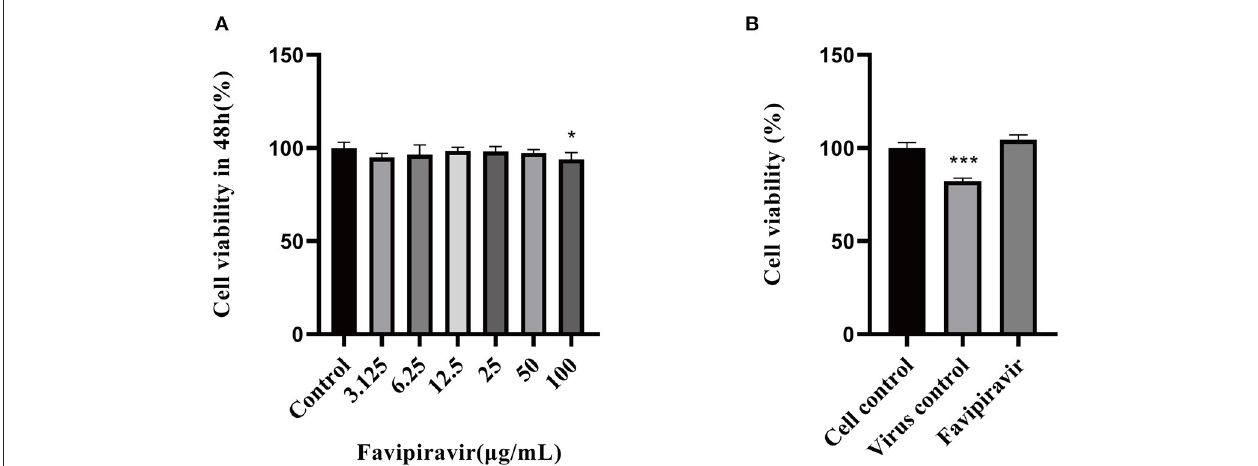
FIGURE 1 | Determination of the maximal noncytotoxic concentration of favipiravir. (A) The viability of Vero cells treated with serial dilutions of favipiravir for 48h from a starting concentration of 100 µ g/ml. (B) The viability of Vero cells treated with 100 TCID 50 peste des petits ruminants virus (PPRV) and favipiravir at maximal non-toxic concentration for 48h (* p < 0.05, *** p < 0.001 vs. the cell control).